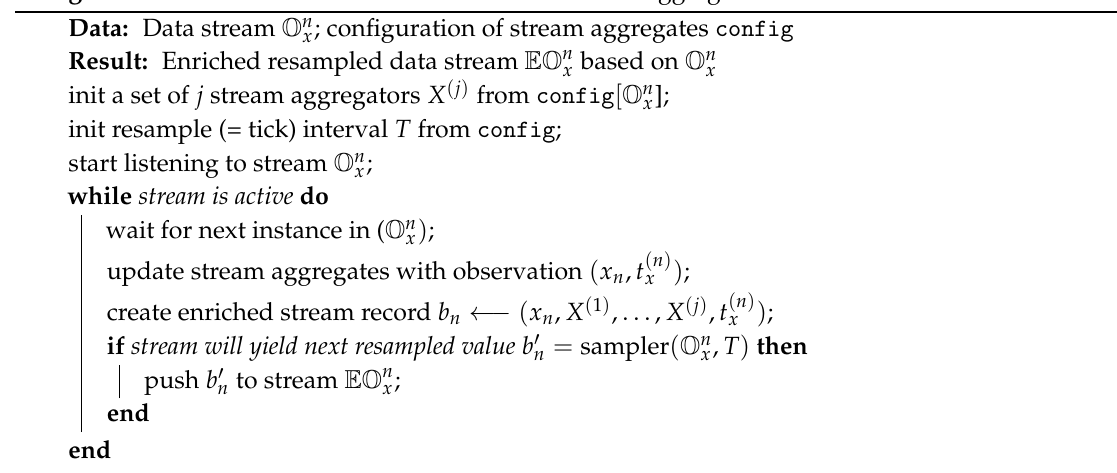
Algorithm 1: Enrichment of a data stream with stream